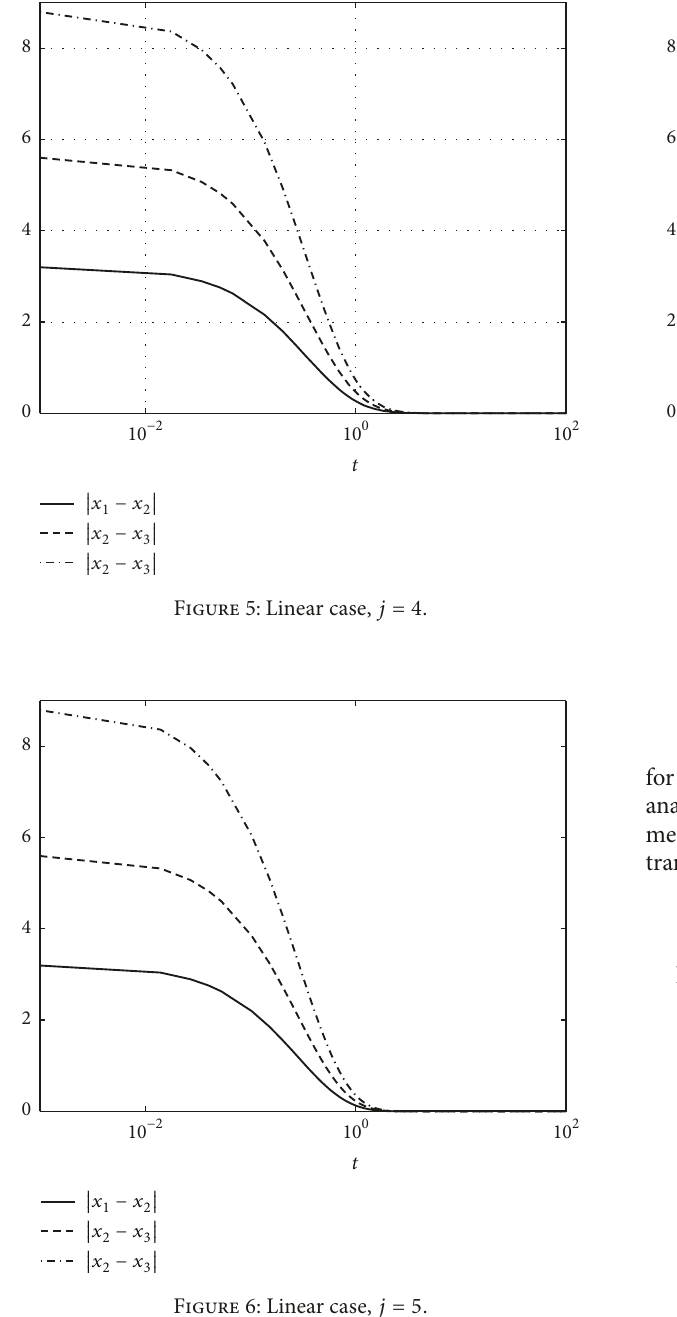
Figure 6: Linear case, 𝑗 = 5 .